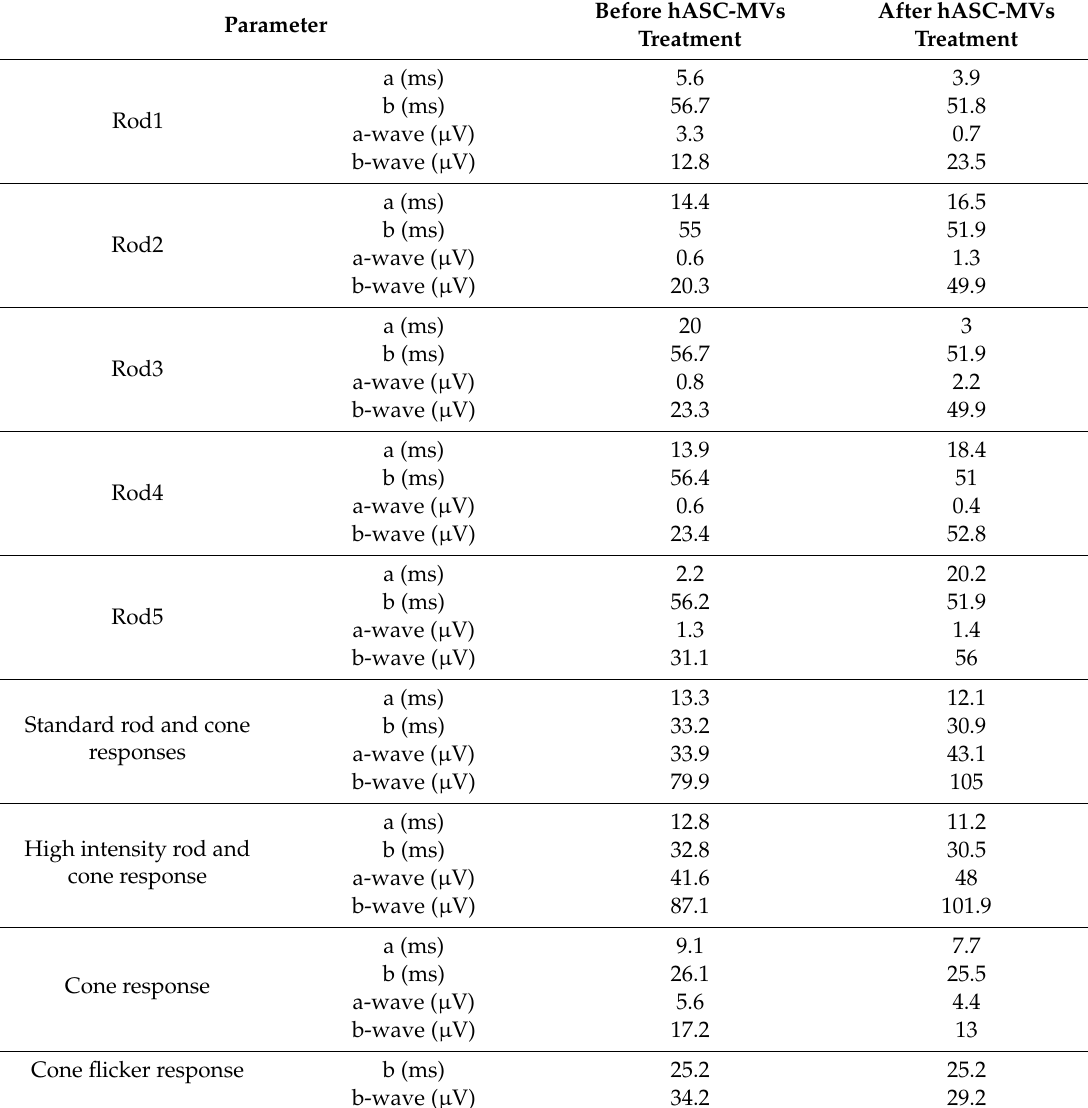
Table 3. The results of ERG analysis using long protocol. Study performed on the Kelpie dog with retinal degeneration of unknown